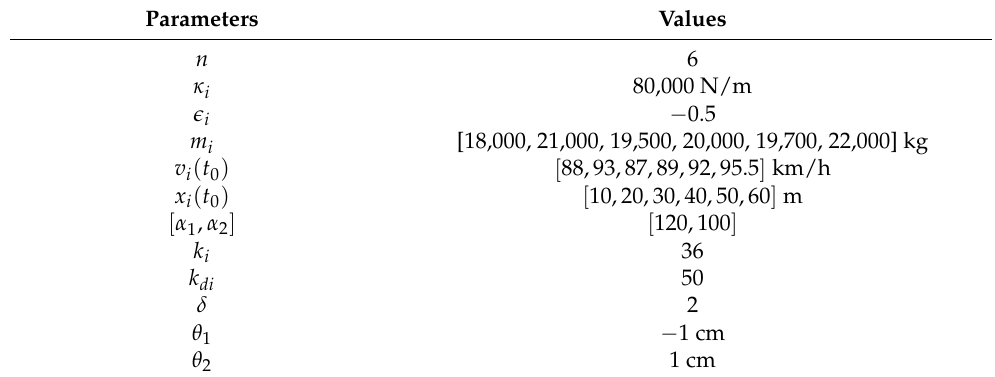
Table 2. Main simulation parameters of the observer-driven distributed consensus braking controller for urban railway trains.